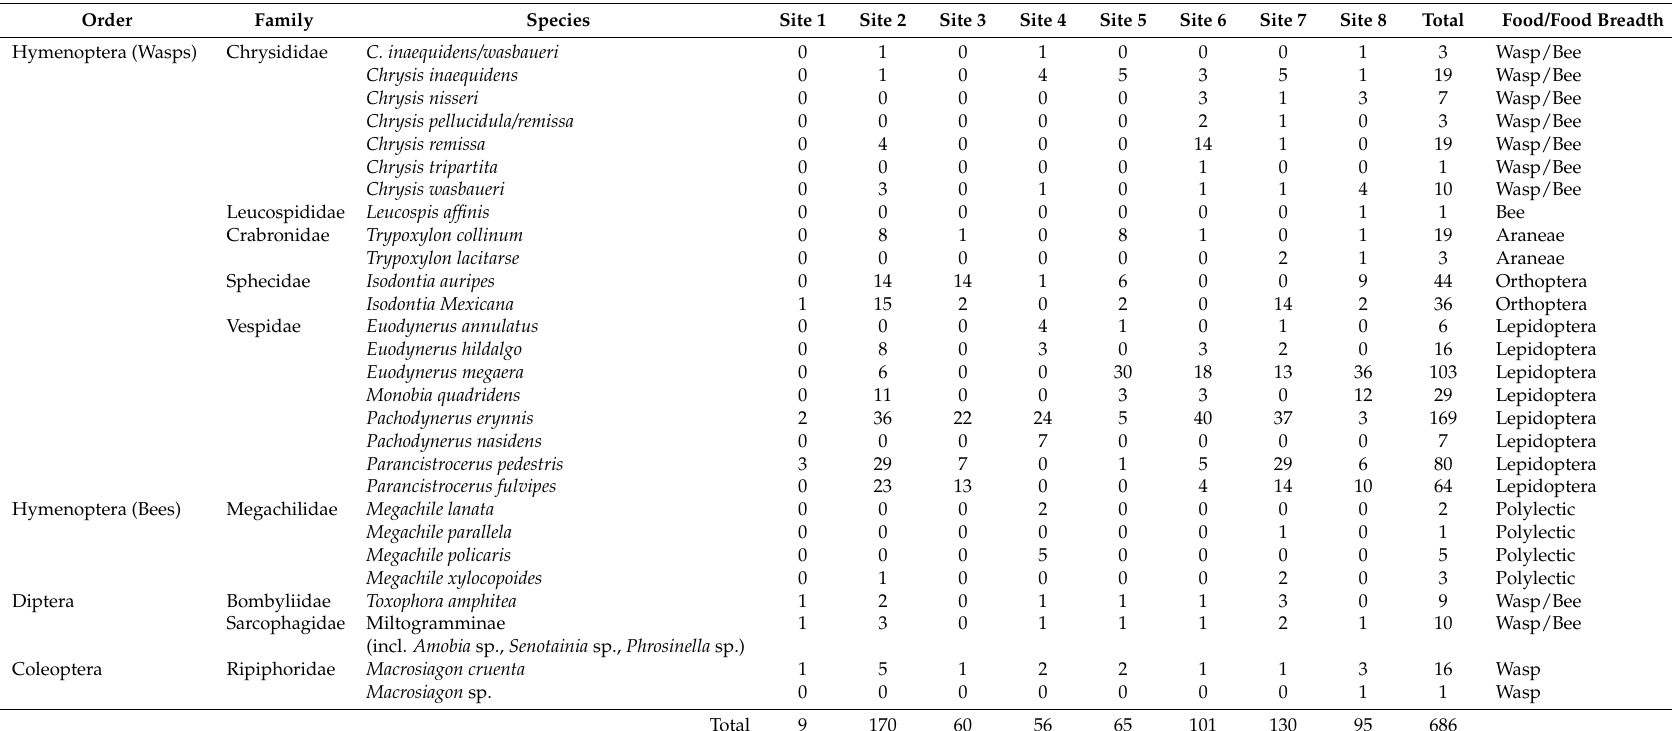
Table 2. List of all insect species and number of reeds occupied by the species in the trap-nests from wildflower and fallow control plots at eight sites in Florida.